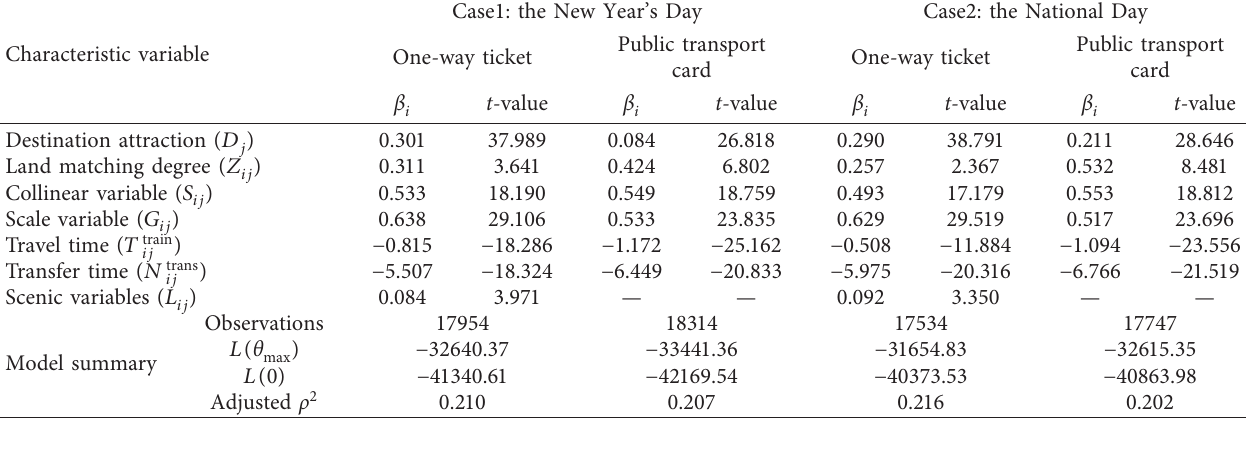
Table 5: Model estimation